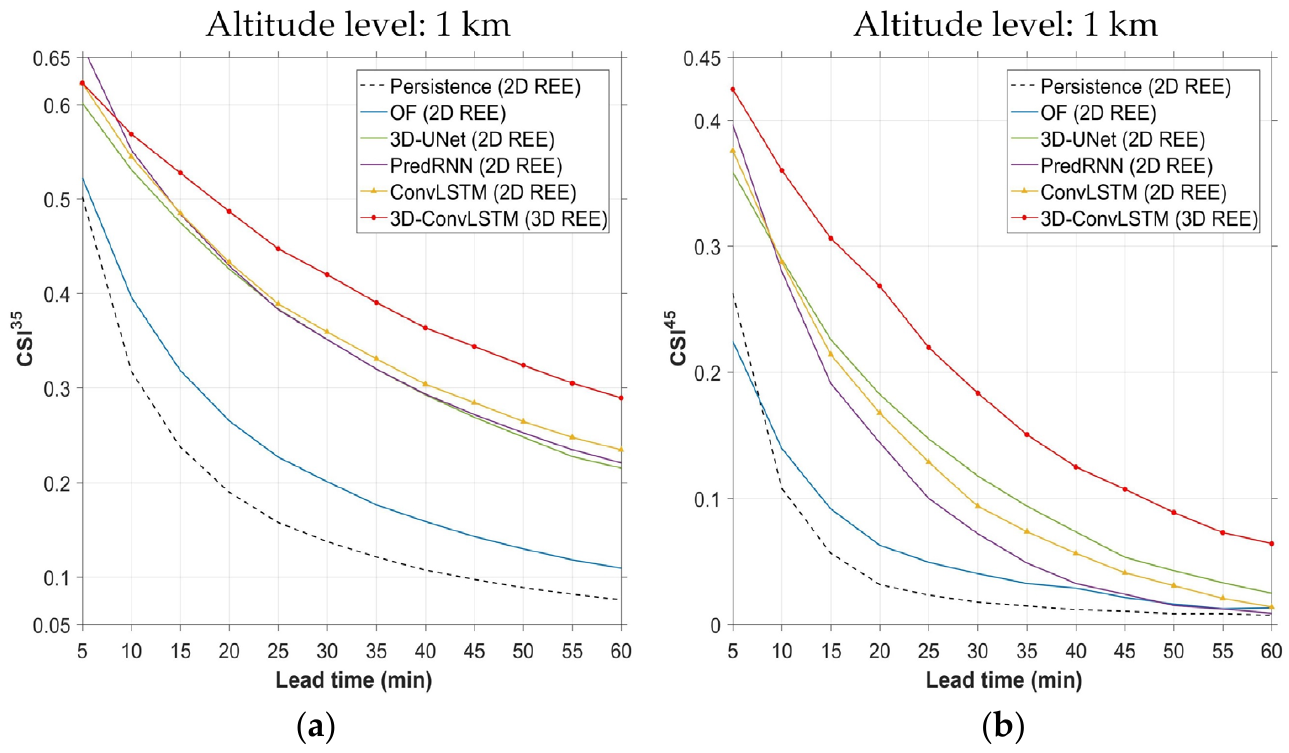
Figure 7. CSI curves of the 2D REE models and the proposed 3D REE model at ( a ) 35 dBZ threshold and ( b ) 45 dBZ threshold for 1 km altitude level.